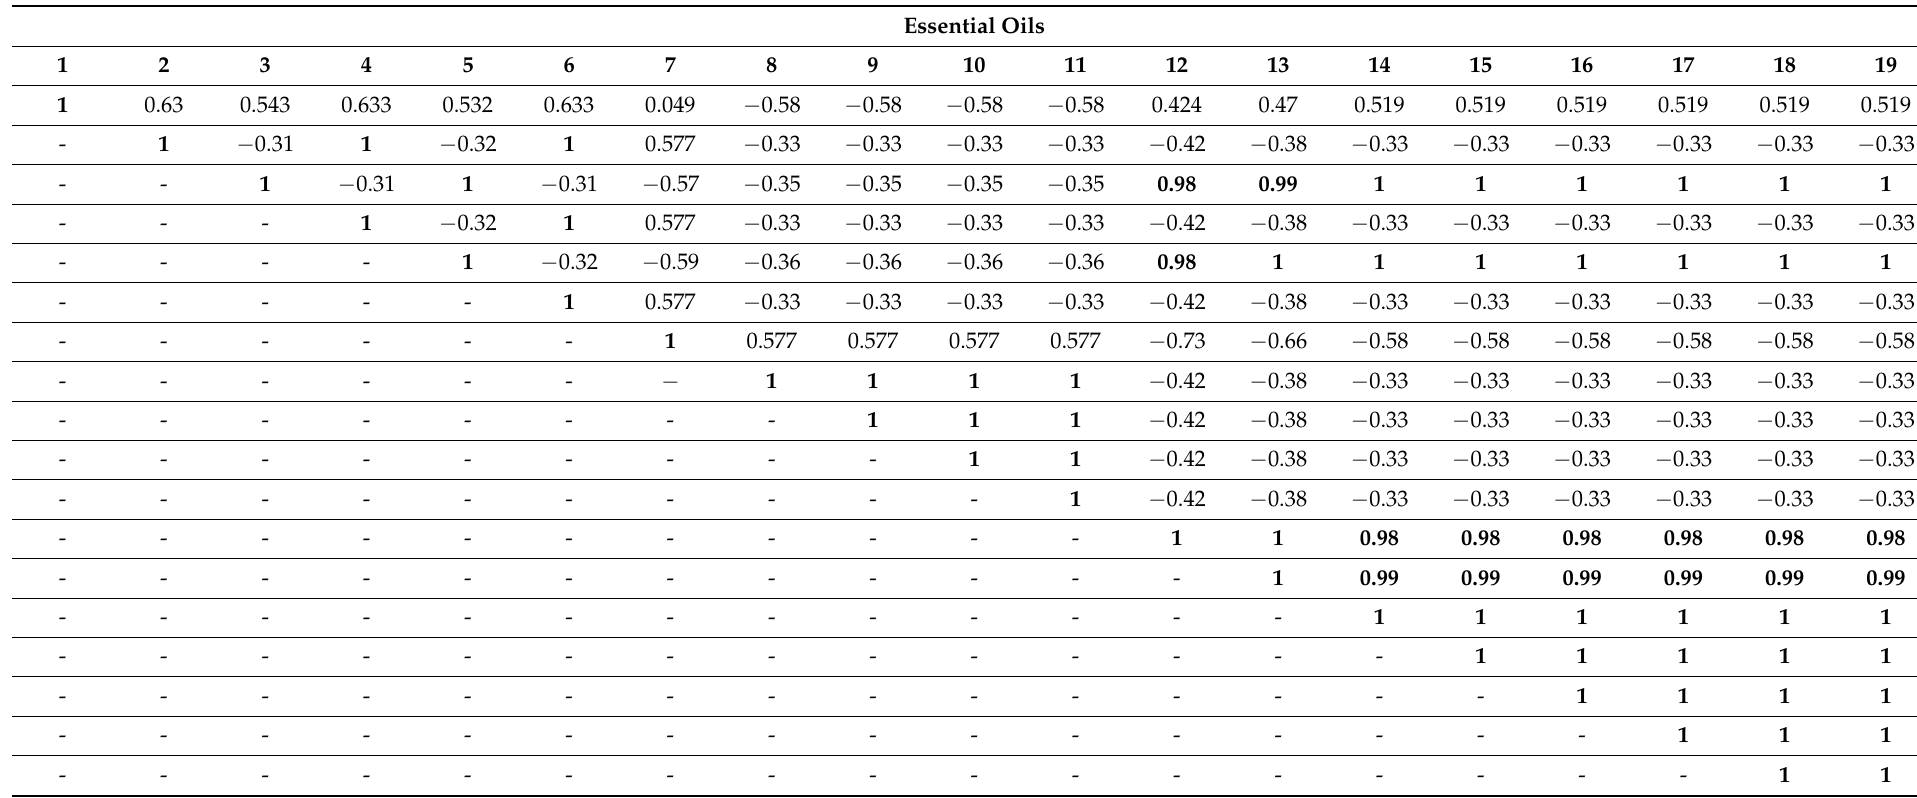
Table 3. r-Pearson. The values in bold are different from 0 with a level of significance of alpha = 0.05. Types of oils considered: 1. Alpha-pinene, 2. Limonene, 3. Beta-pinene, 4. Myrcene, 5. P-cymene, 6. Beta-phellandrene, 7. Monoyl oxide, 8. Germacrene D, 9. Alpha-campholenal, 10. Beta-bourbenene, 11. Sesquiterpenes exclusives, 12. Gamma-terpinene, 13. Terpinen 4-ol,